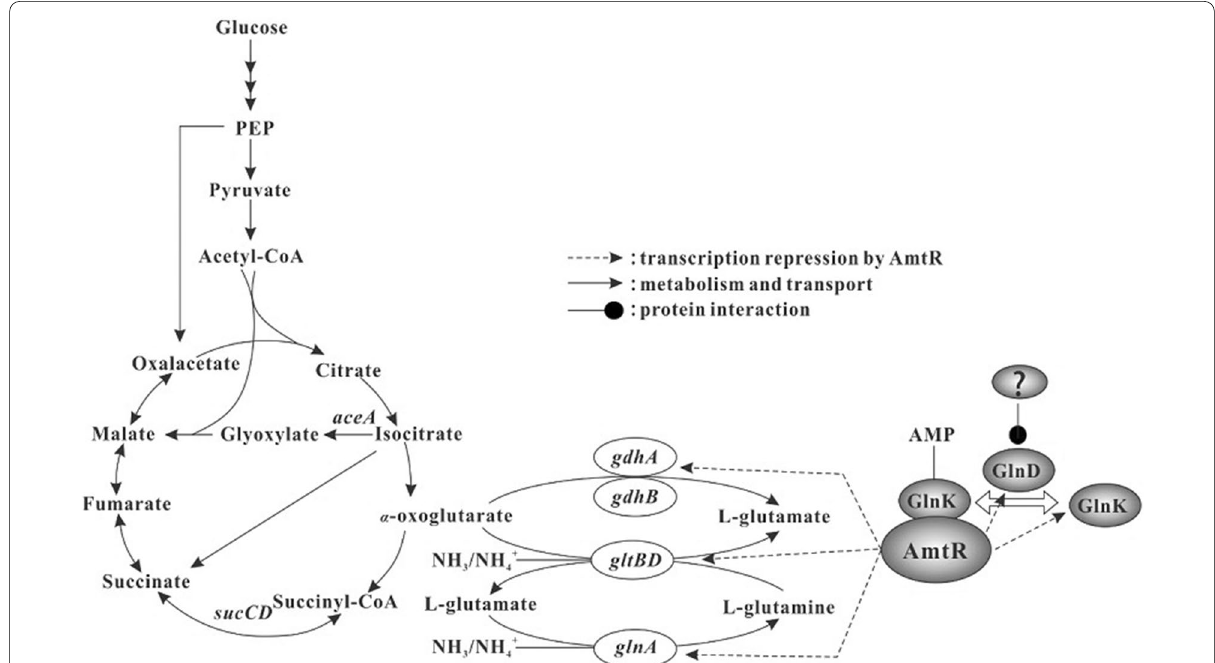
Fig. 1 Ammonium assimilation and AmtR regulation in C. glutamicum Description of all genes has been given in Additional file 1: Table